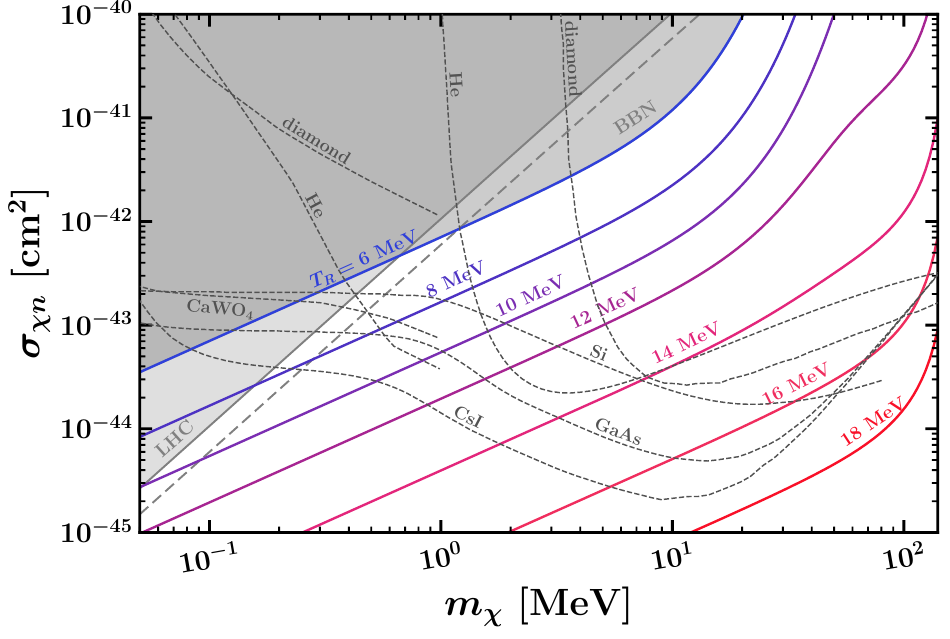
Figure 3 . The dark matter-nucleon scattering cross section as a function of m χ which yields the correct relic abundance for y ψ = y χ = 1 . The colored contours correspond to different reheating temperatures. The gray shaded regions are excluded by the LHC and BBN, while the dashed gray lines show the projected sensitivities of future experiments [5, 10, 12–14, 16, 17]. the same reheating temperatures as in figure 2, the gray regions correspond to the same bounds, and y = y = 1 again. The LHC constraint again comes from direct searches χ ψ for ψ (see eq. (2.8)), and the dashed gray line assumes instead a possible future bound of & 2 TeV from the m ψ